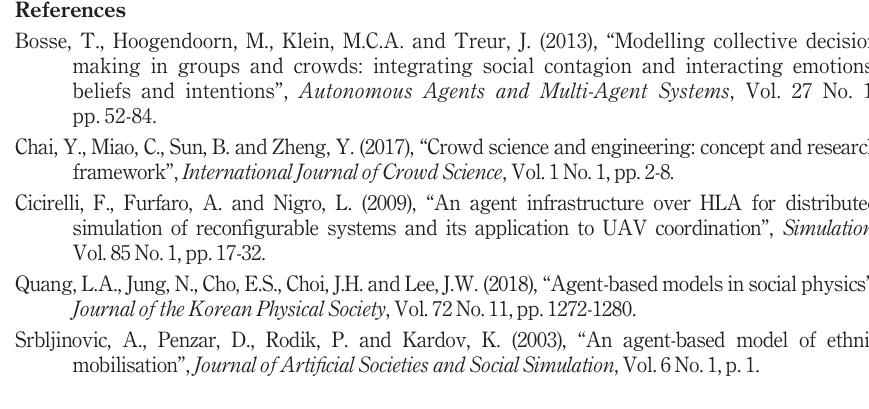
This paper adopts a data-driven architecture, the architecture mainly relies on XML fi les to drive the entire simulation process. XML fi les have strong readability and do not need special software to read. XML fi les isolate the various stages of crowd network simulation with static fi les and construct several simulations at the same time, which improves the ef fi ciency. In the playback process of the simulation results, The XML fi le can be read directly for playback without considering the ef fi ciency of the machine.